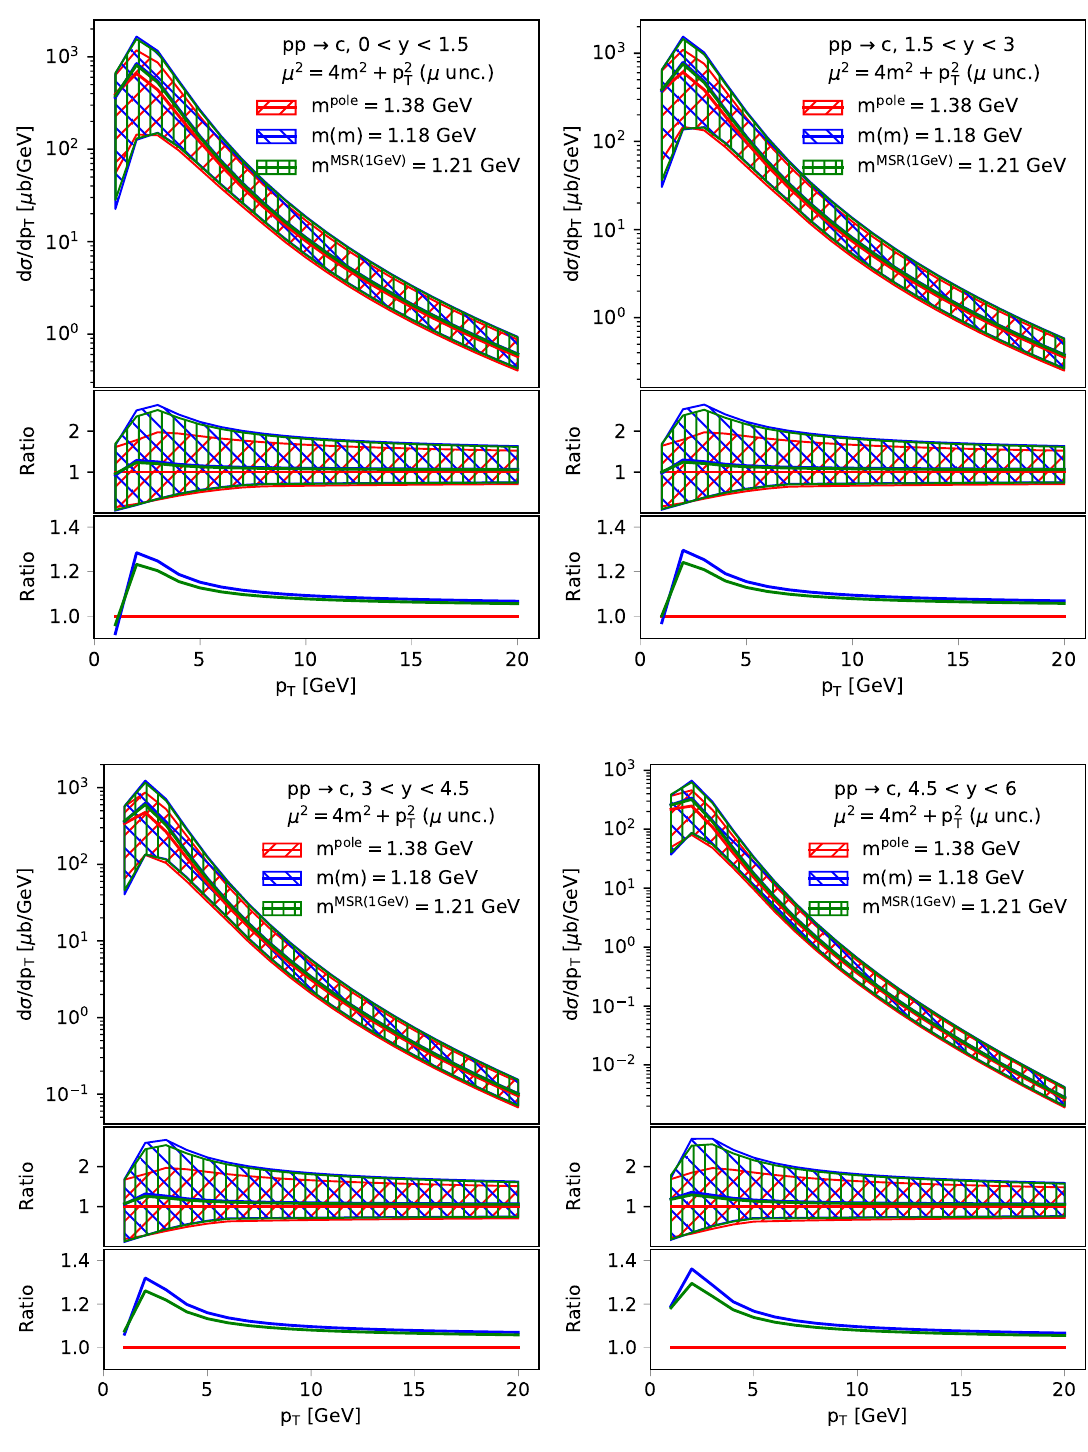
Figure 3 . Same as figure 2, but for the charm-mass value m c ( m c ) = 1.18 GeV (converted to m MSR (1 GeV) = 1.21 GeV and m pole = 1.38 GeV), as extracted in the ABMP16 NLO c c